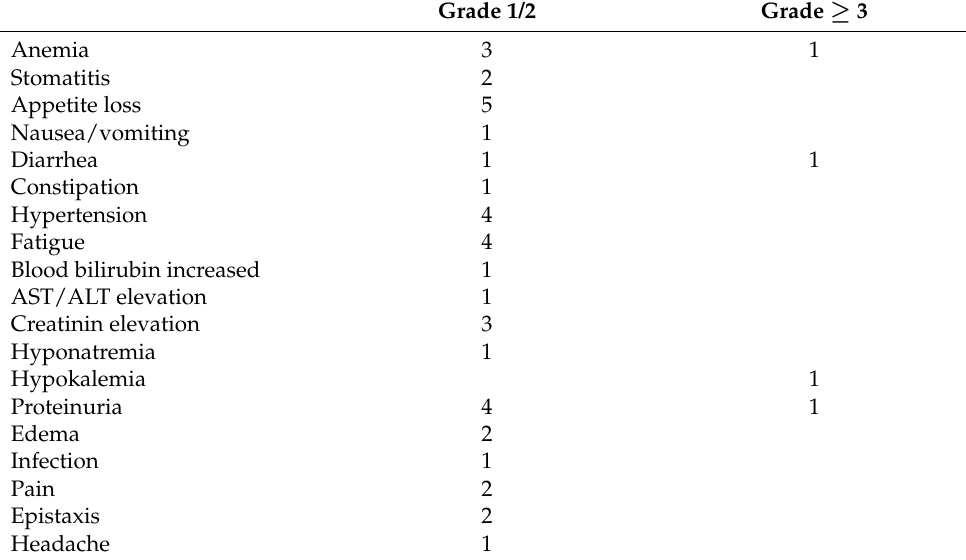
Table 2. Adverse events (n =